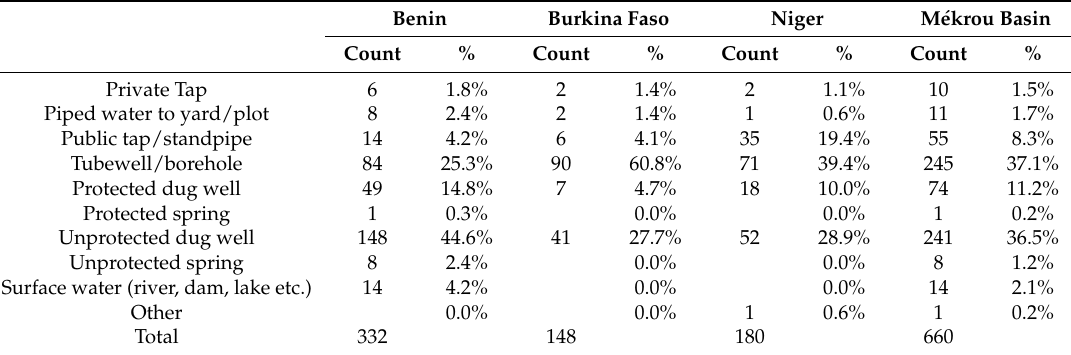
Table 2. Main sources of provided domestic water.